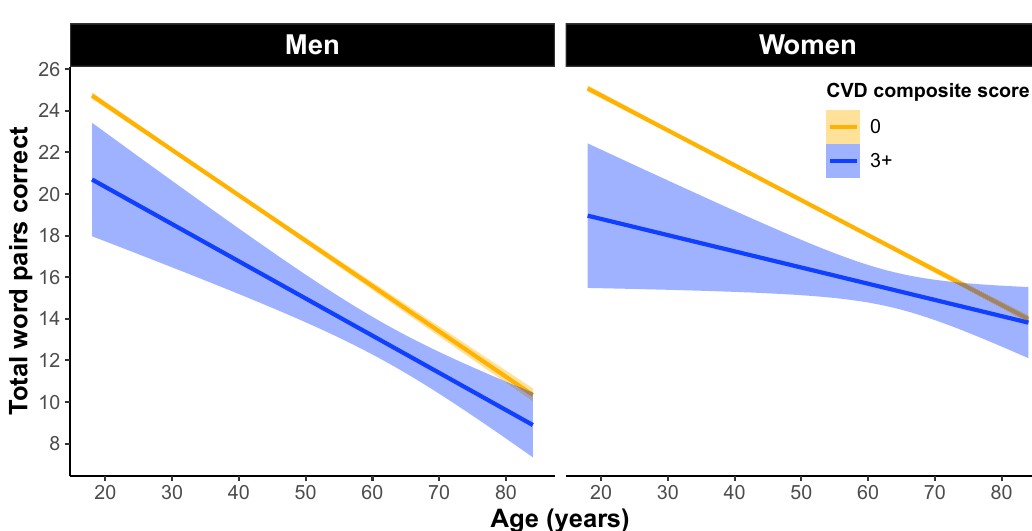
Figure 4. The main effect of a self-reported CVD composite score on PAL performance across 18–85 year olds separately between men and women. Simple effects analyses revealed the negative impact of cardiovascular disease on memory had slightly larger effect sizes in men compared to women in the 3 group (men: β = − 1.80 word pairs, std error = 0.41, p = 1.3e−5; women: β = − 1.27 word pairs, std error = 0.35, p =